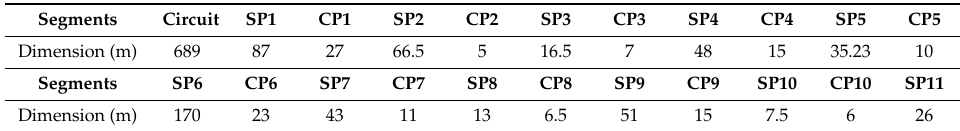
Table 2. The total dimensions of the circuit and of each segment. SP is the abbreviation of straight path. CP is the abbreviation of curved